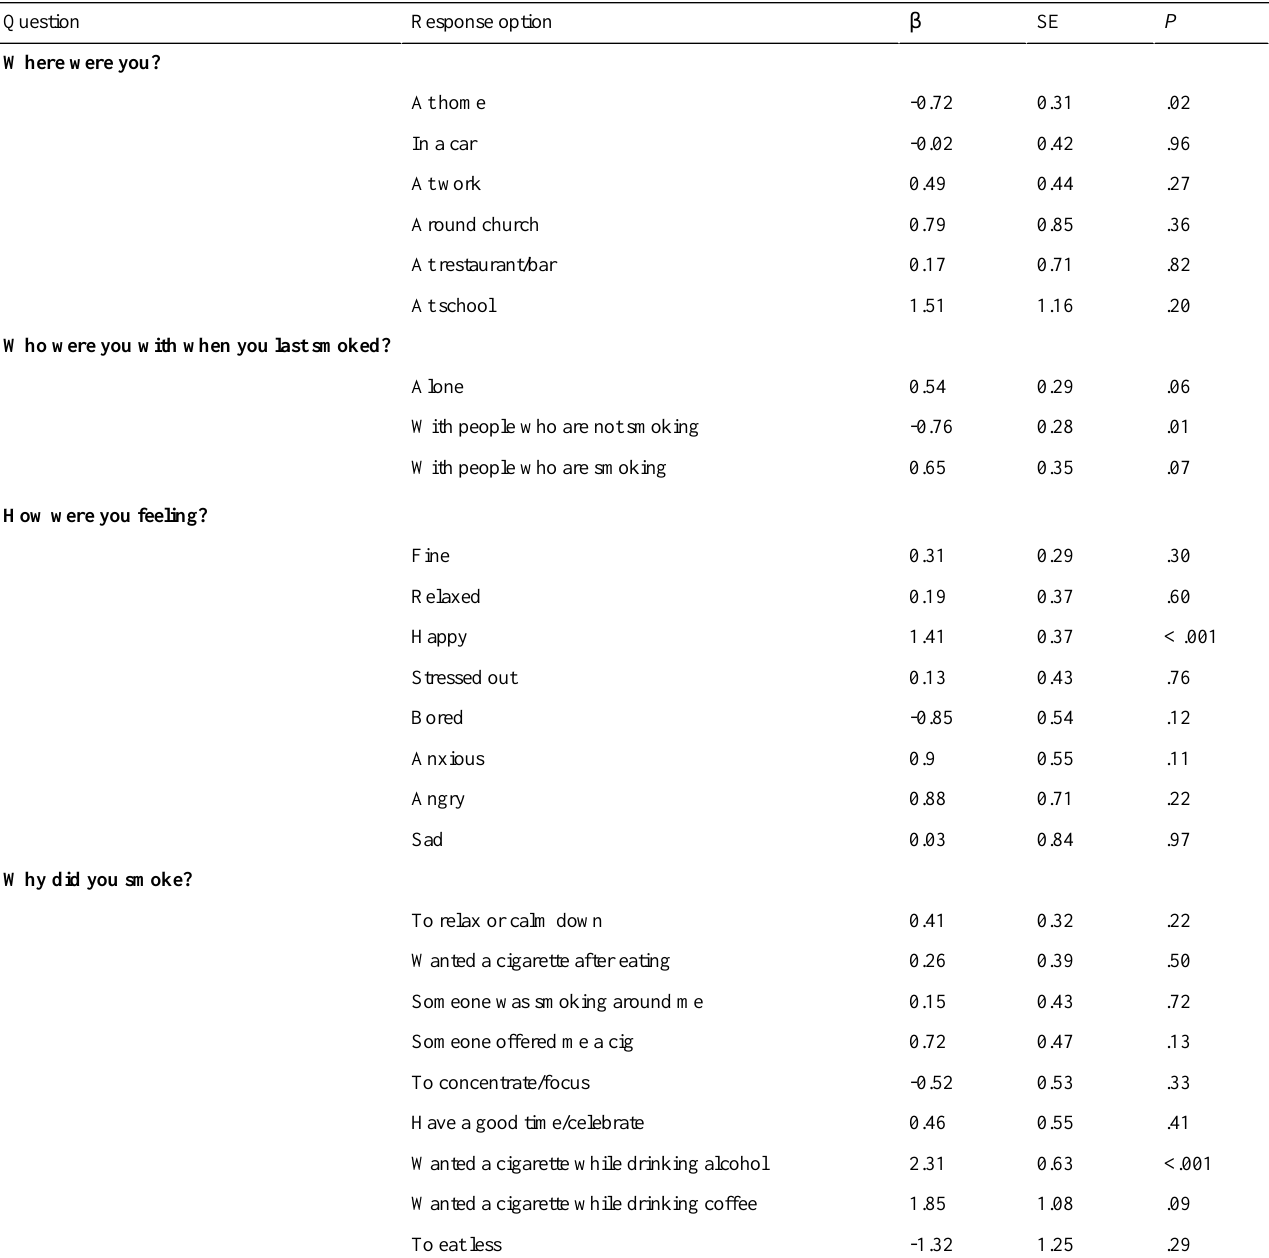
P SE β Response optionQuestion